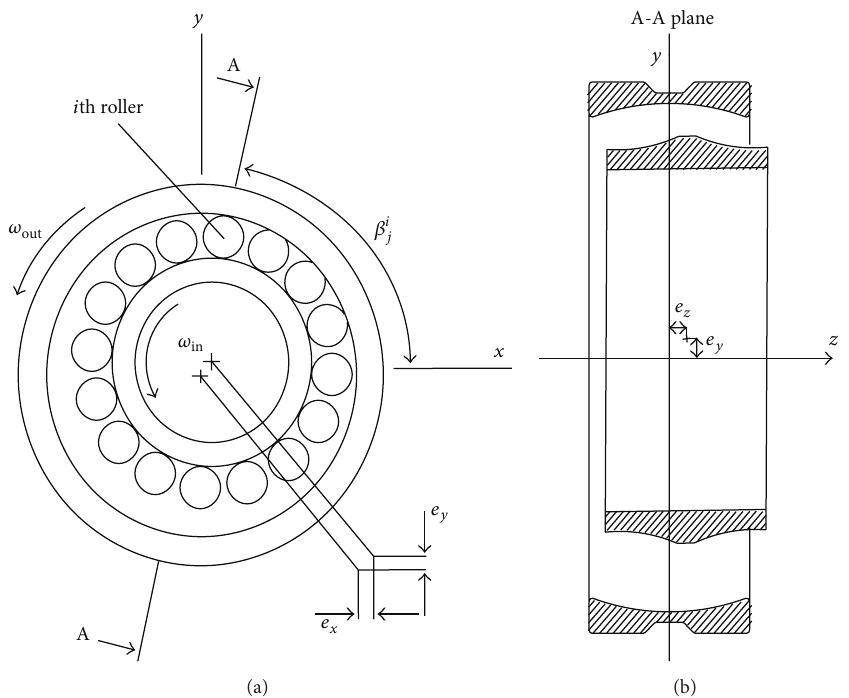
Figure 3: Displacements in the global 𝑥𝑦𝑧 -coordinate [20].